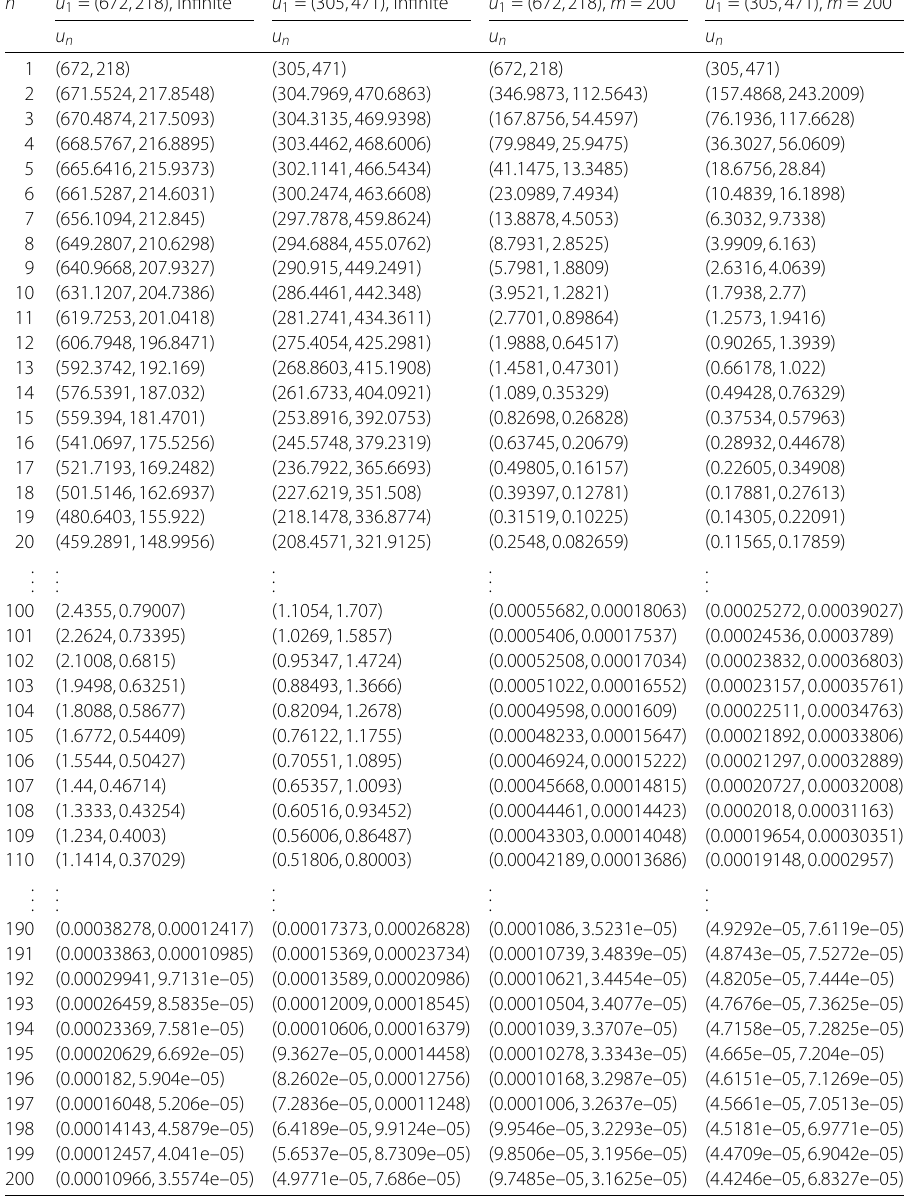
Table 1 Some values of { u n } from Example 4.1 with starting points of Case 1 and 2